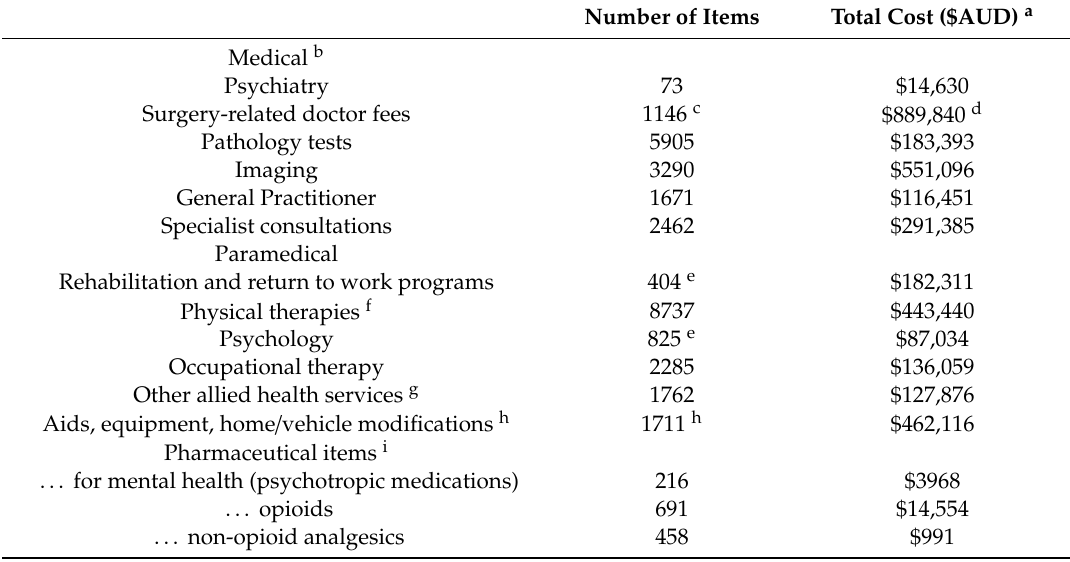
Table 1. Summary of Medical, Paramedical and Pharmaceutical Items (Total) Received by the Sample in the First 12 Months after